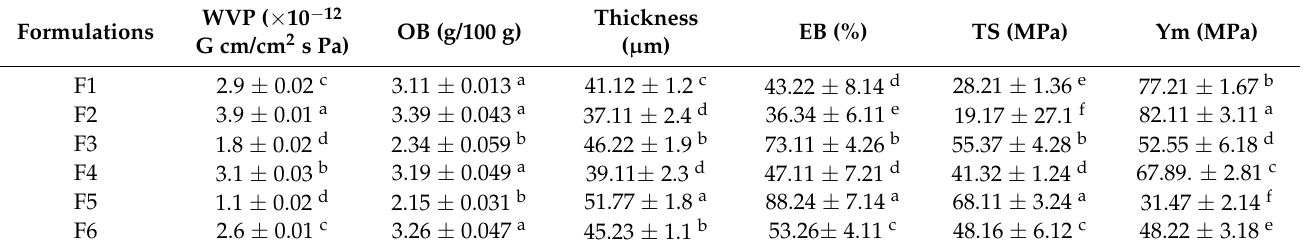
Table 2. Mechanical properties WVP, oxygen barrier property (OB), thickness, EB, TS, and Young’s modulus (Ym) of the